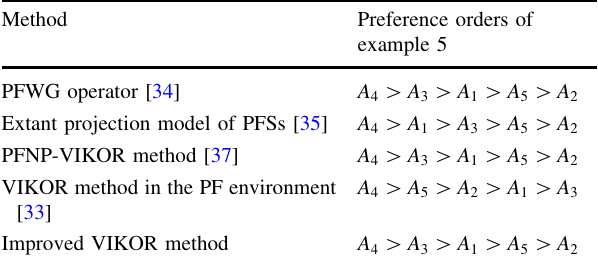
Table 6 Comparisons of the different methods with the example 7 [34] Method Preference orders of